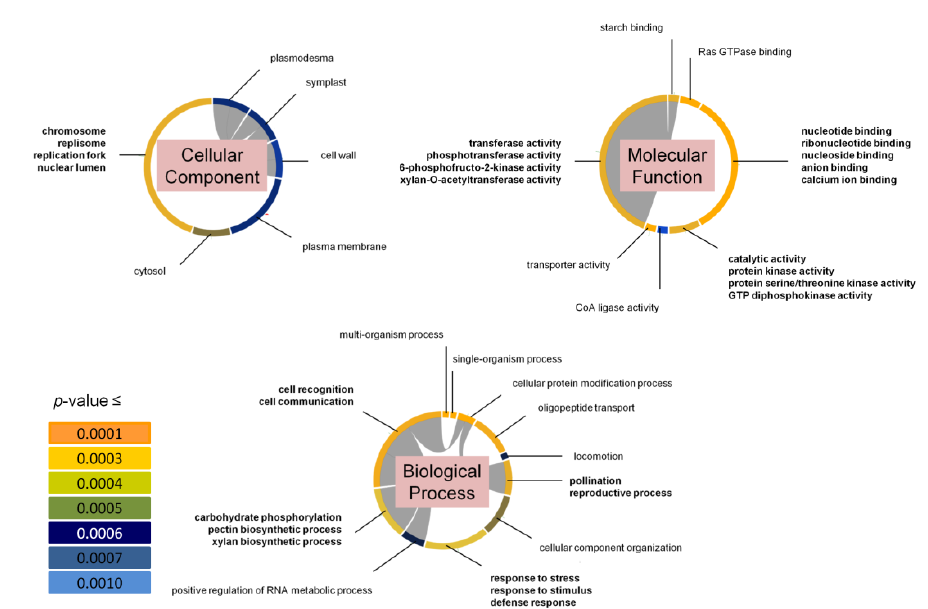
Figure 5. Gene Ontology (GO) term enrichment of annotated genes found in regions of the 20 Multiple-Phenotype QTL shown in Figure 4. The segment color corresponds to different p values (as shown). The segment length corresponds to the number of genes contributing to that GO term/cluster. In Bold: multiple GO terms clustered together based on overlapping genes.